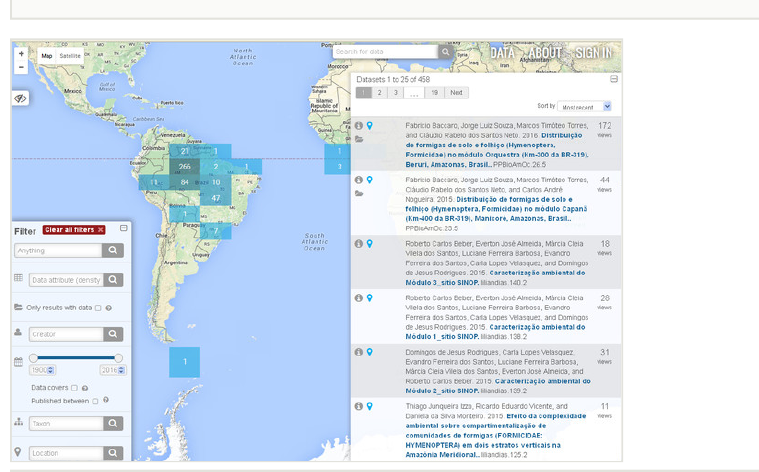
The public data repository provided by the Knowledge Network for Biocomplexity (KNB). https://knb.ecoinformatics.org/#data/page/0